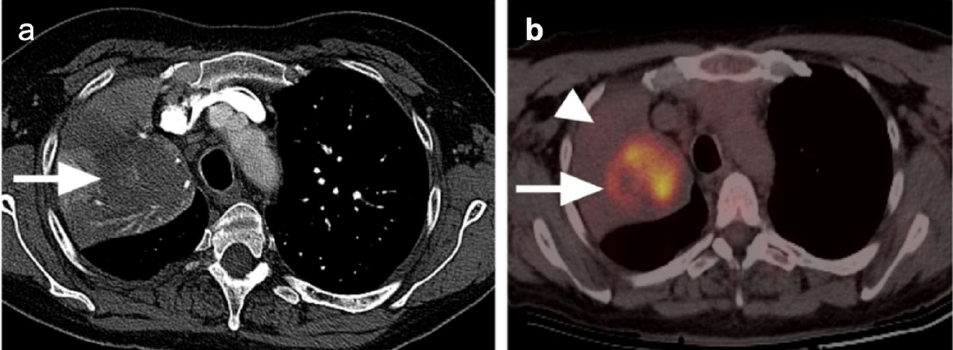
Figure 8. Non-small cell lung cancer. A 59-year-old male patient presented with large opacity in the right upper lobe. ( a ) Axial image from contrast enhanced CT study demonstrated a large irregularly hypoattenuating mass associated with lobar atelectasis ( white arrow ). However, it is difficult to delineate the mass lesion itself from the associated atelectasis or determine whether the mass extends to the pleural surface; ( b ) Fused axial FDG PET-CT images clearly differentiate the more central hypermetabolic mass lesion, with areas of internal photopenia representing areas of necrosis ( white arrow ). The area peripheral to this hypermetabolic mass is without significant metabolic activity and represents post-obstructive collapse of the pulmonary parenchyma distal to the mass ( white arrowhead ).